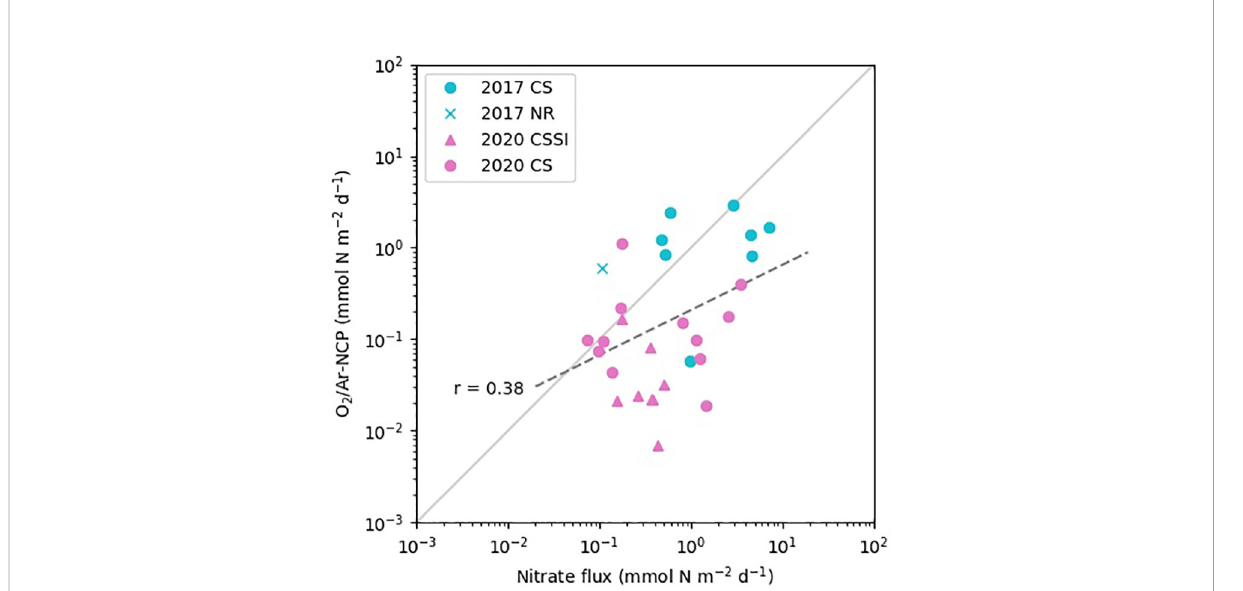
FIGURE 8 Correlation between NCP in the mixed layer and NO 3- fl ux from the nitracline to the bottom of the mixed